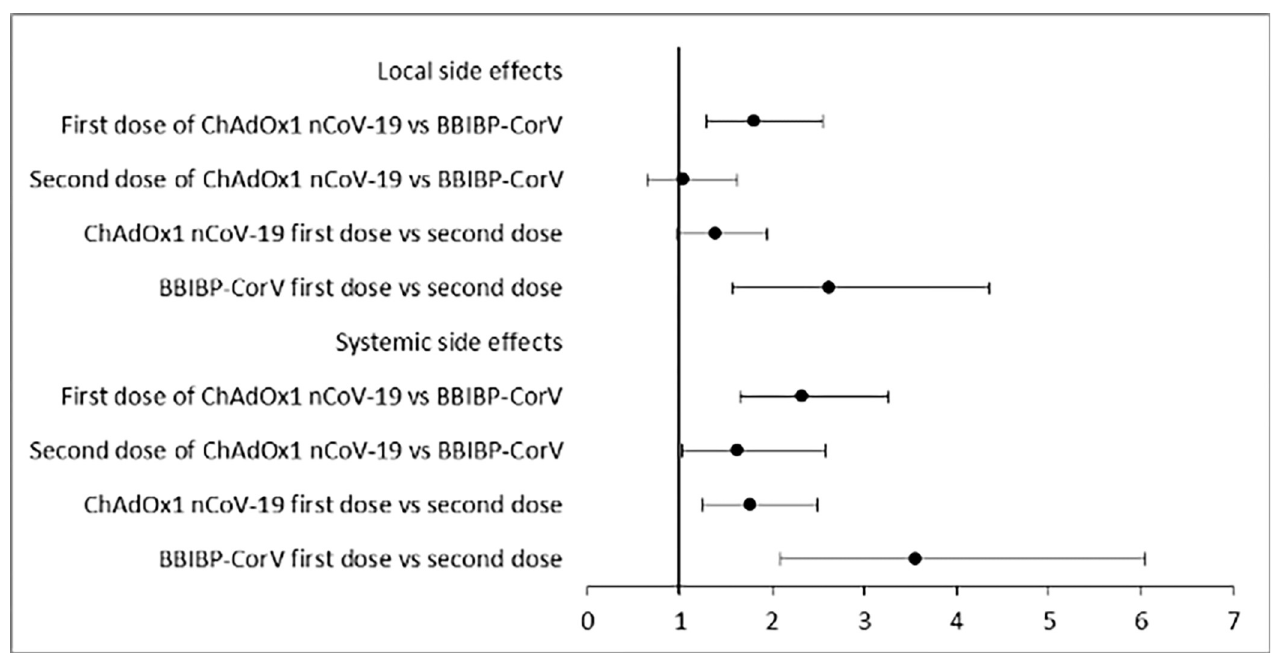
Fig 1. Risk of adverse events according to vaccine type and doses (OR with 95% CI adjusted for age, sex, comorbidities, and previous SARS-CoV-2 infection). https://doi.org/10.1371/journal.pone.0272729.g001 and tenderness, headache, fever, fatigue, etc. were reported lower among the British popula- tion [10], and comparatively higher in Iraqi and Korean populations [16, 17] than in our study.